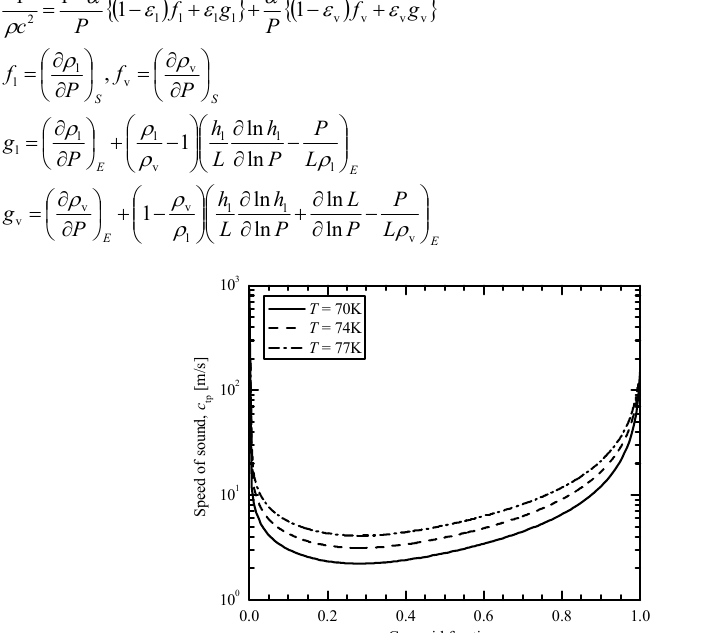
Fig.12 Variation of the speed of sound in a gas-liquid two-phase flow toward the gas void fraction and the fluid